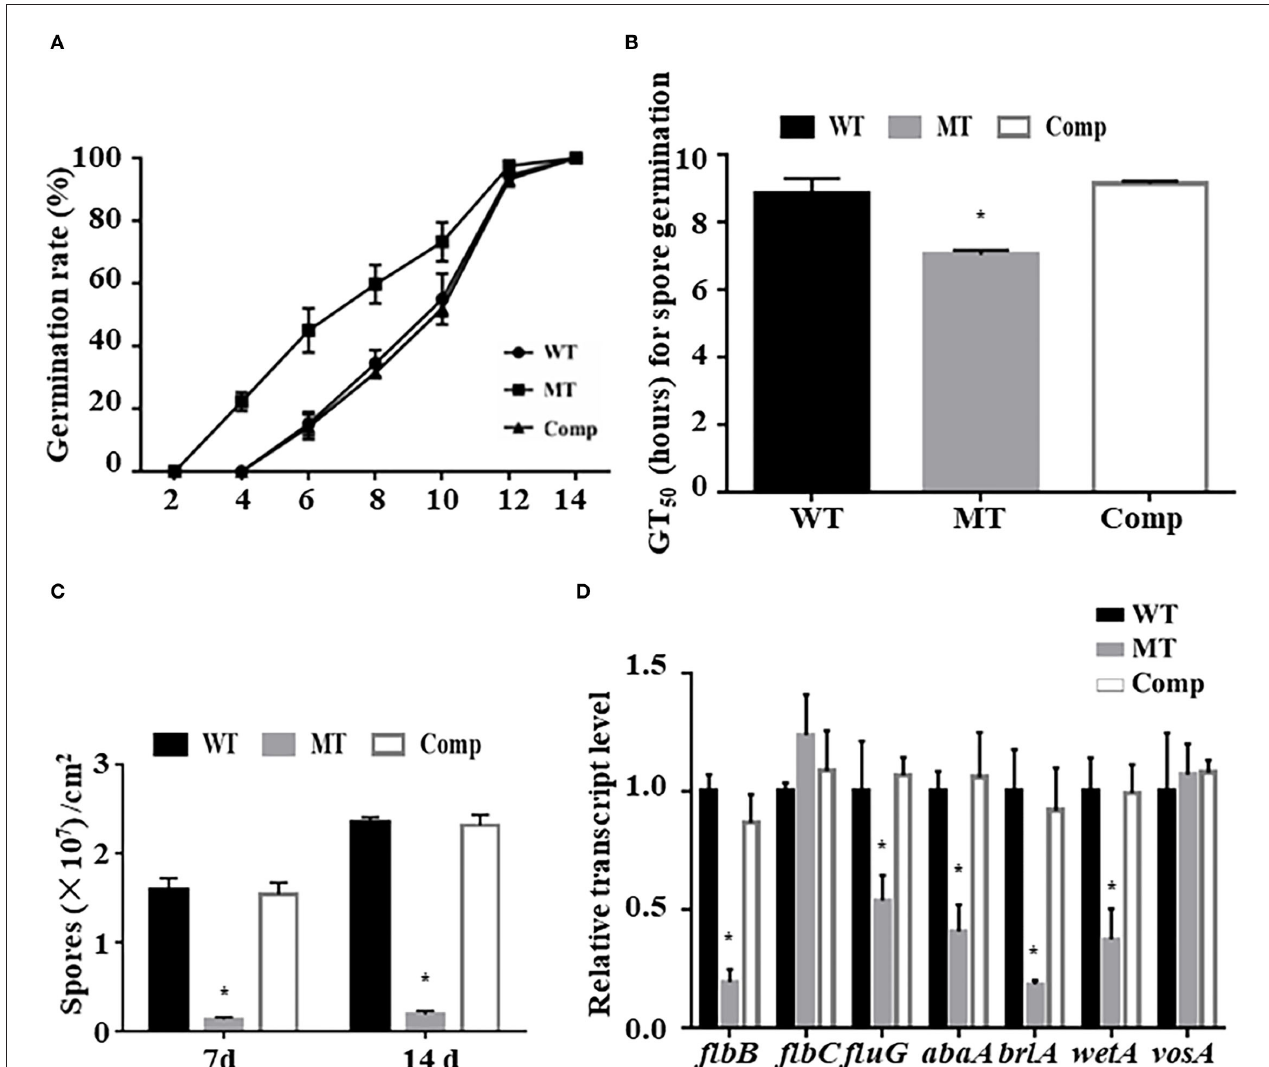
FIGURE 2 | Impact of MrUbp14 deletion on conidial germination and conidiation. (A) Conidial germination rate. The rates of conidial germination for relative strains were measured after inoculation at different times. (B) Half-time of germination (GT 50 ) for relative strains incubated on potato dextrose agar (PDA) at 25 ◦ C for 24h. (C) Conidial yields for relative strains after cultivation on PDA for different time points. (D) Expression levels of relative genes of different strains during initial conidiation stage. Error bars indicate standard deviation (SD) of three biological replicates. The asterisk (*) indicates p <